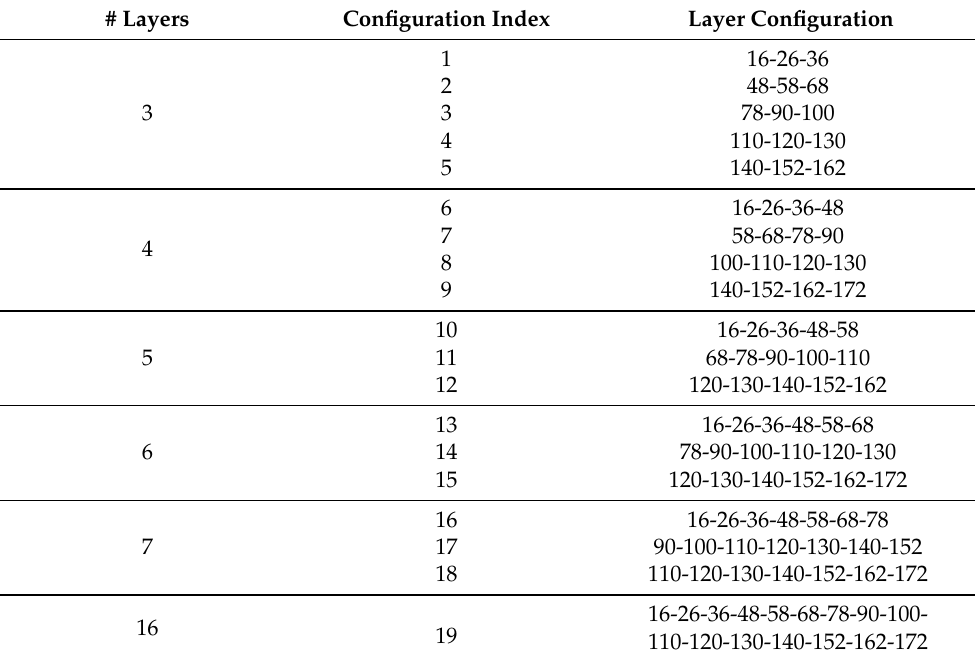
Table 2. Layer number configuration of ResNet used in our